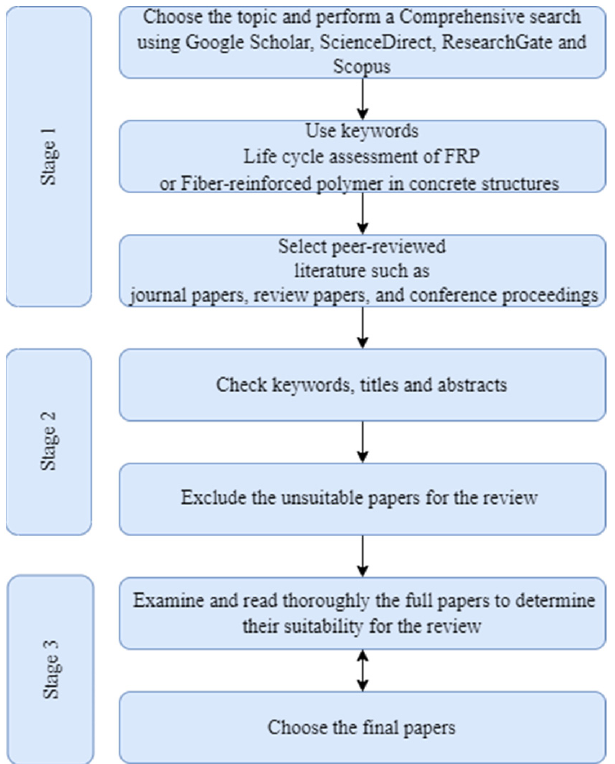
Figure 2. Research methodology.